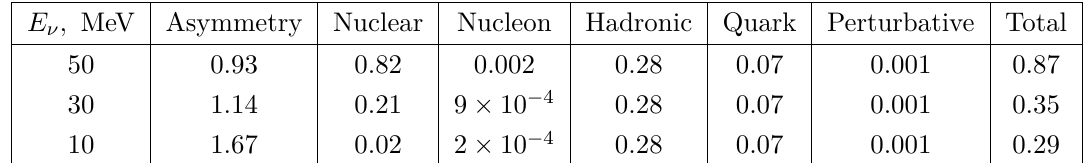
Table 3 . CE ν NS flavor asymmetry, ( σ ν relative error (in % ) for an incident neutrino energy E